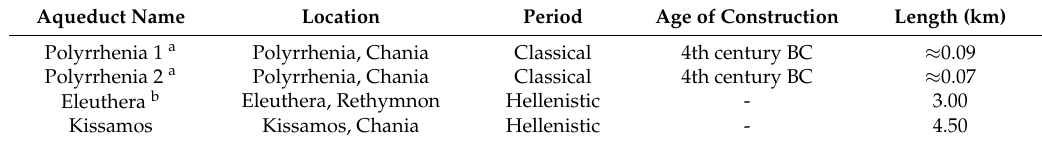
Table 3. Characteristics of Classical and Hellenistic aqueducts (adapted from De Feo et al.